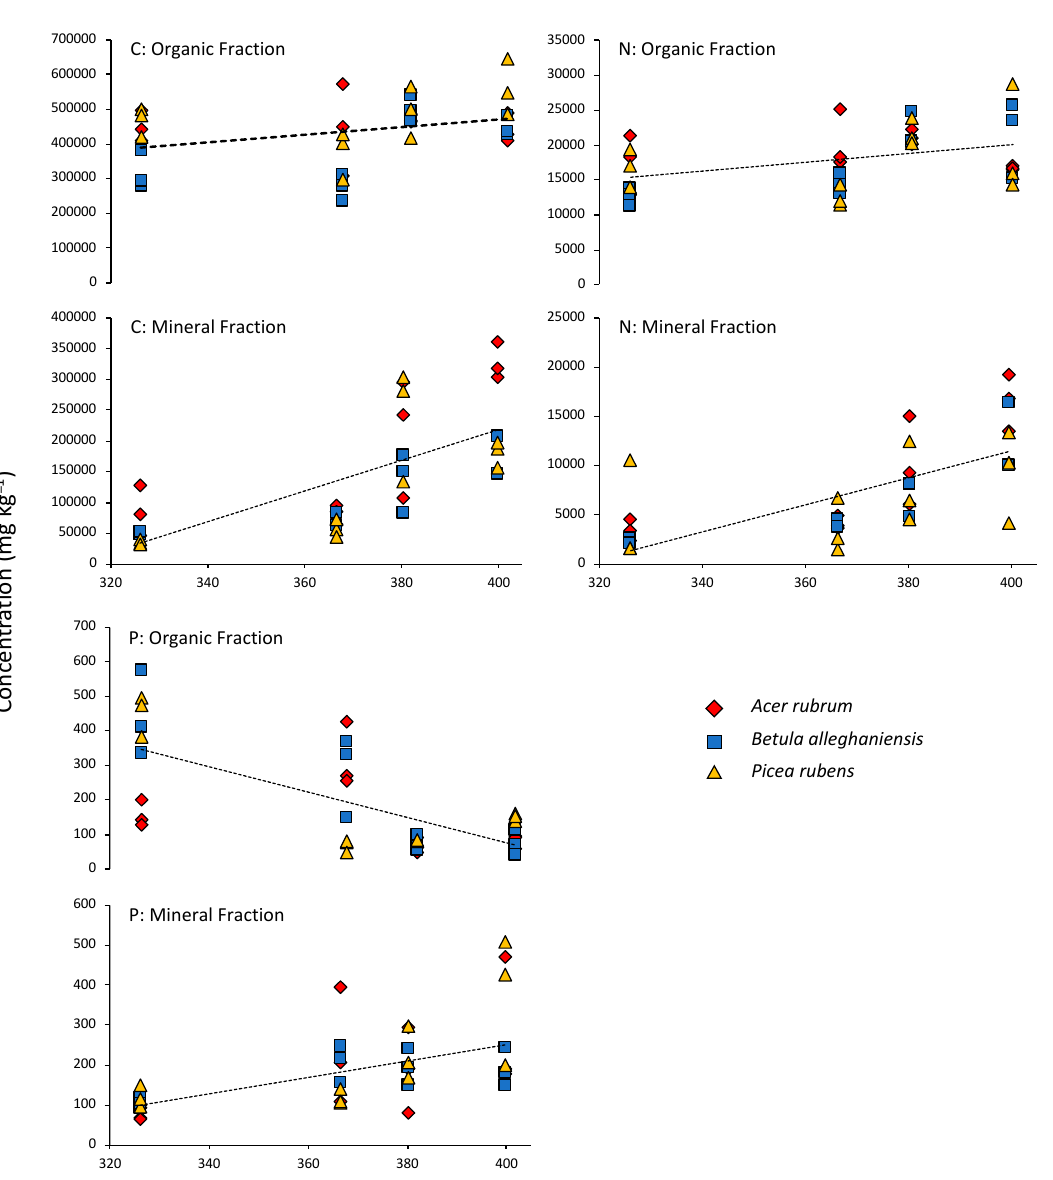
Figure 1. Mean soil C, N, and P concentrations for organic and mineral fractions as functions of estimated total N deposition into high elevation spruce forests. Each symbol represents the mean beneath three replicate trees of each species. Regression lines are best fits across all species. Slopes ± SE [(mg kg − 1 ) (kg N ha − 1 ) − 1 ] for the regressions are: C org, 1133 ± 574, C min , 2421 ± 435, N org , 64.7 ± 25.9, N min , 131.0 ± 20.9, P org , − 3.76 ± 0.70, and P min , 2.36 ± 0.56. All slopes are significant ( p < 0.05).